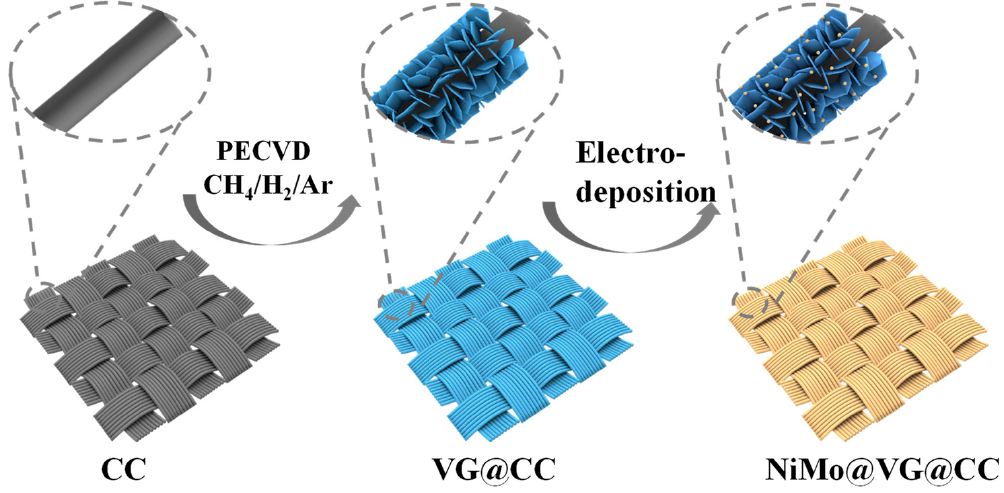
Figure 1. Schematic of the synthesis process of NiMo@VG@CC.